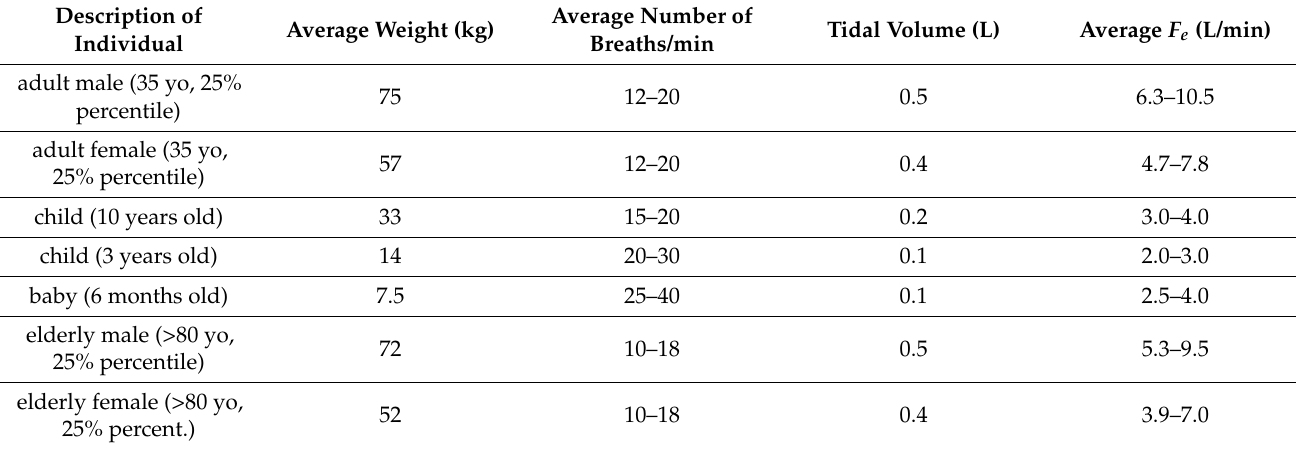
Table 2. Exhaled air flow rates for individuals at different ages and